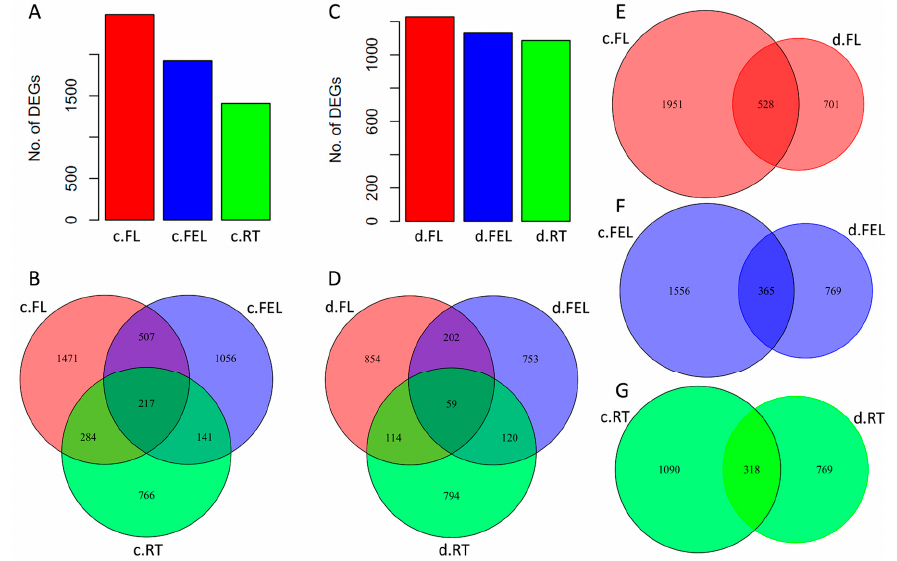
Figure 1. Transcriptome pro fi ling of cassava in response to cold and drought stresses. Differentially expressed (DE) genes identified in FL, FEL, and RT under cold stress ( A ) and their Venn diagrams ( B ). DE genes identified in FL, FEL, and RT under drought stress ( C ) and their Venn diagrams ( D ). Venn diagrams of DE genes between cold and drought stresses in FL ( E ), FEL ( F ), and RT ( G ), respectively. c.FL, c.FEL, and c.RT represent FL, FEL, and RT samples under cold stress, while d.FL, d.FEL, and d.RT represent FL, FEL and RT samples under drought stress.